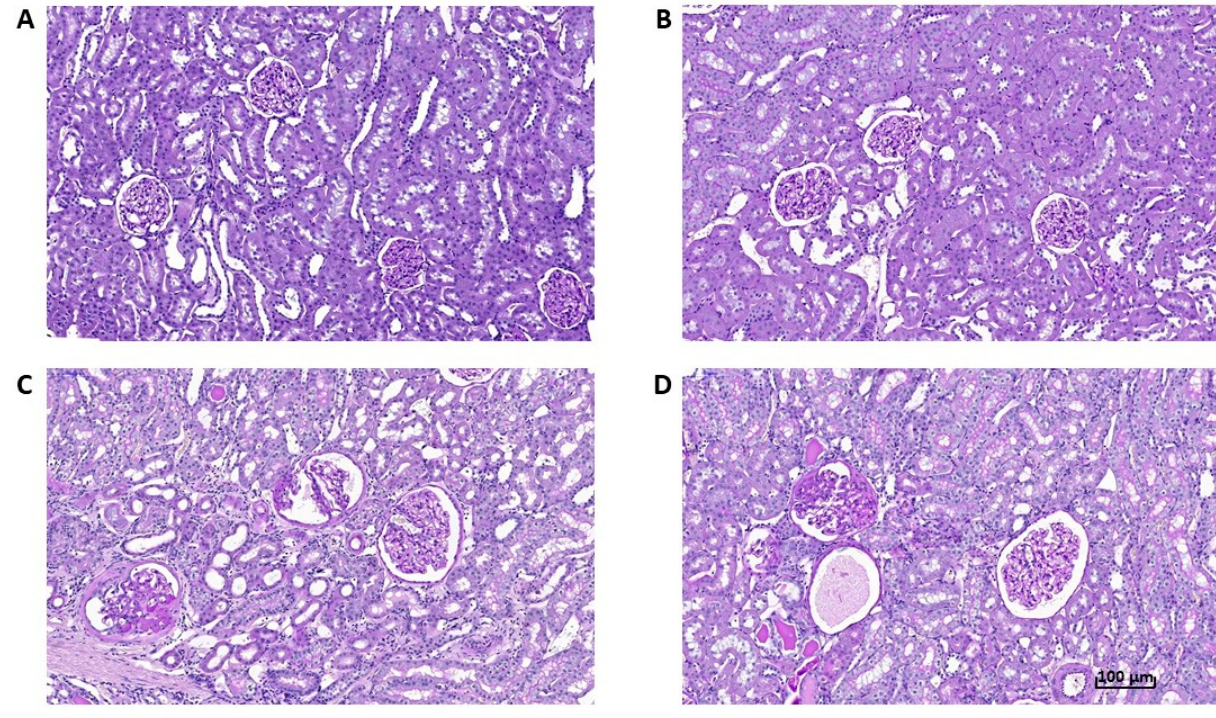
Figure 4. Representative histological images of renal cortex (PAS, 200 × ) (PAS, original objective 20 × ) of young ( A , B ) and adult ( C , D ) untreated ( A , C ) and empagliflozin-treated SHR-CRP rats ( B , D ). A scale bar is shown in Figure 4D.